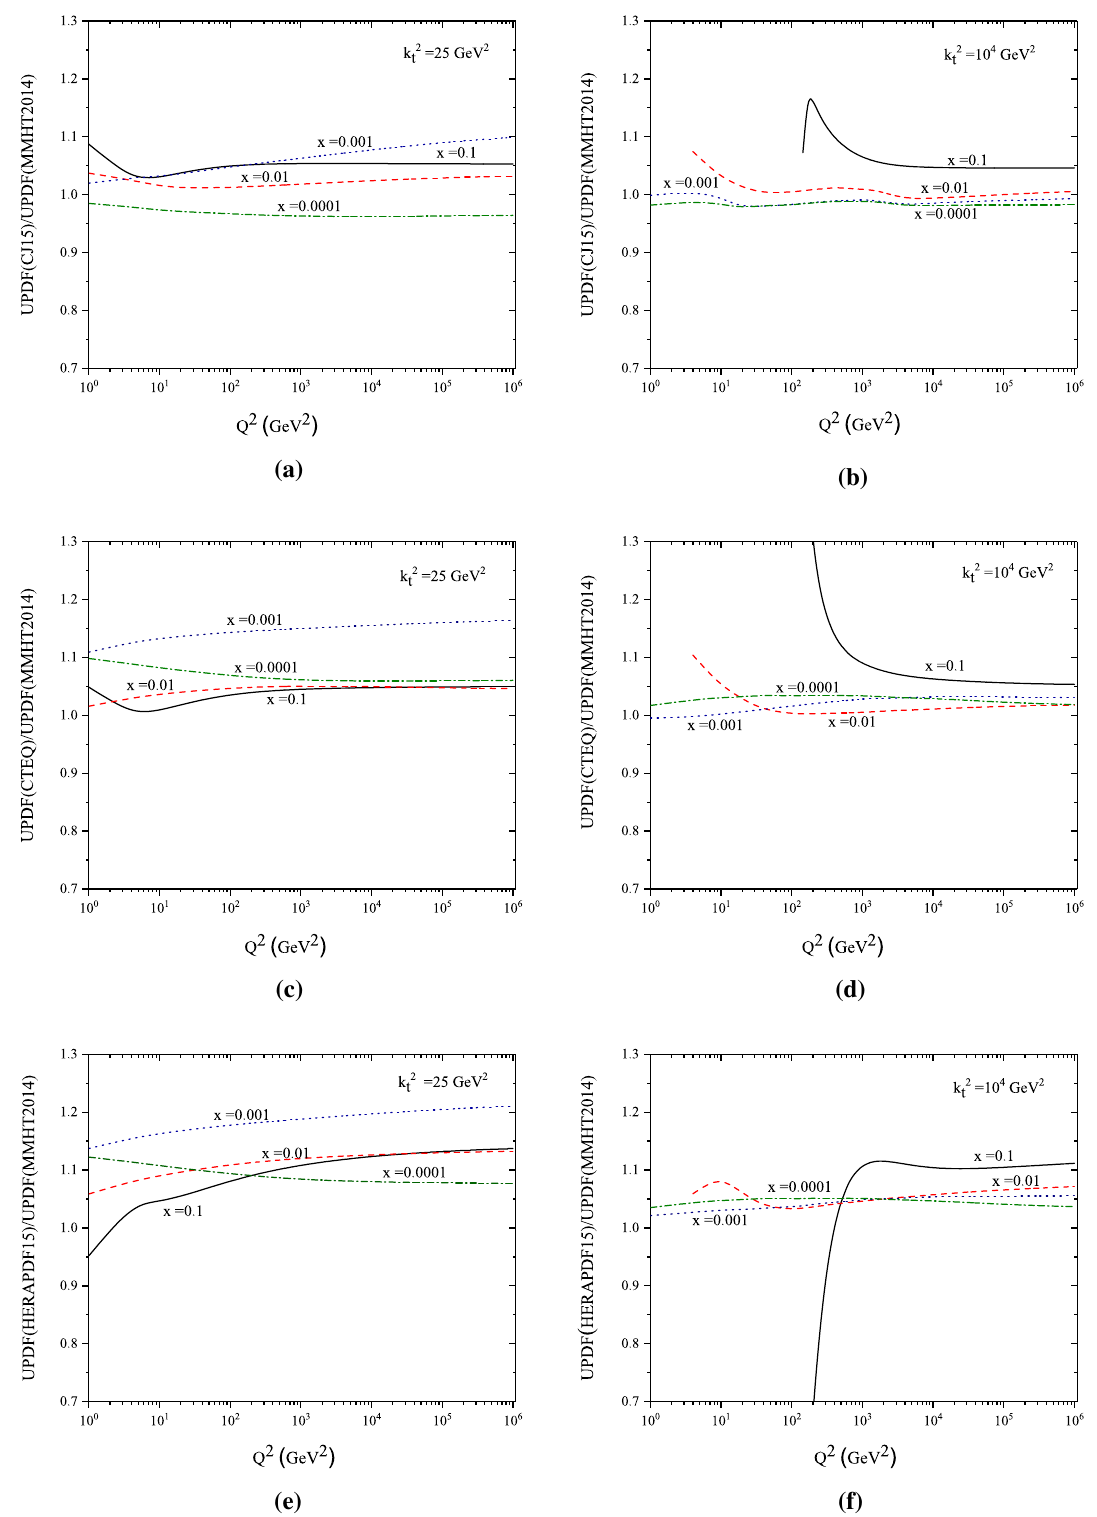
Fig. 2 The different up quark UPDFs ratios of various groups PDFs sets with respect to MMHT2014 one, at the two k 2 t and four x values: the panels a –